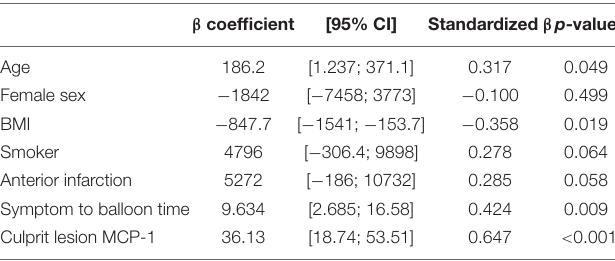
TABLE 2 | Determinants of enzymatic infarct